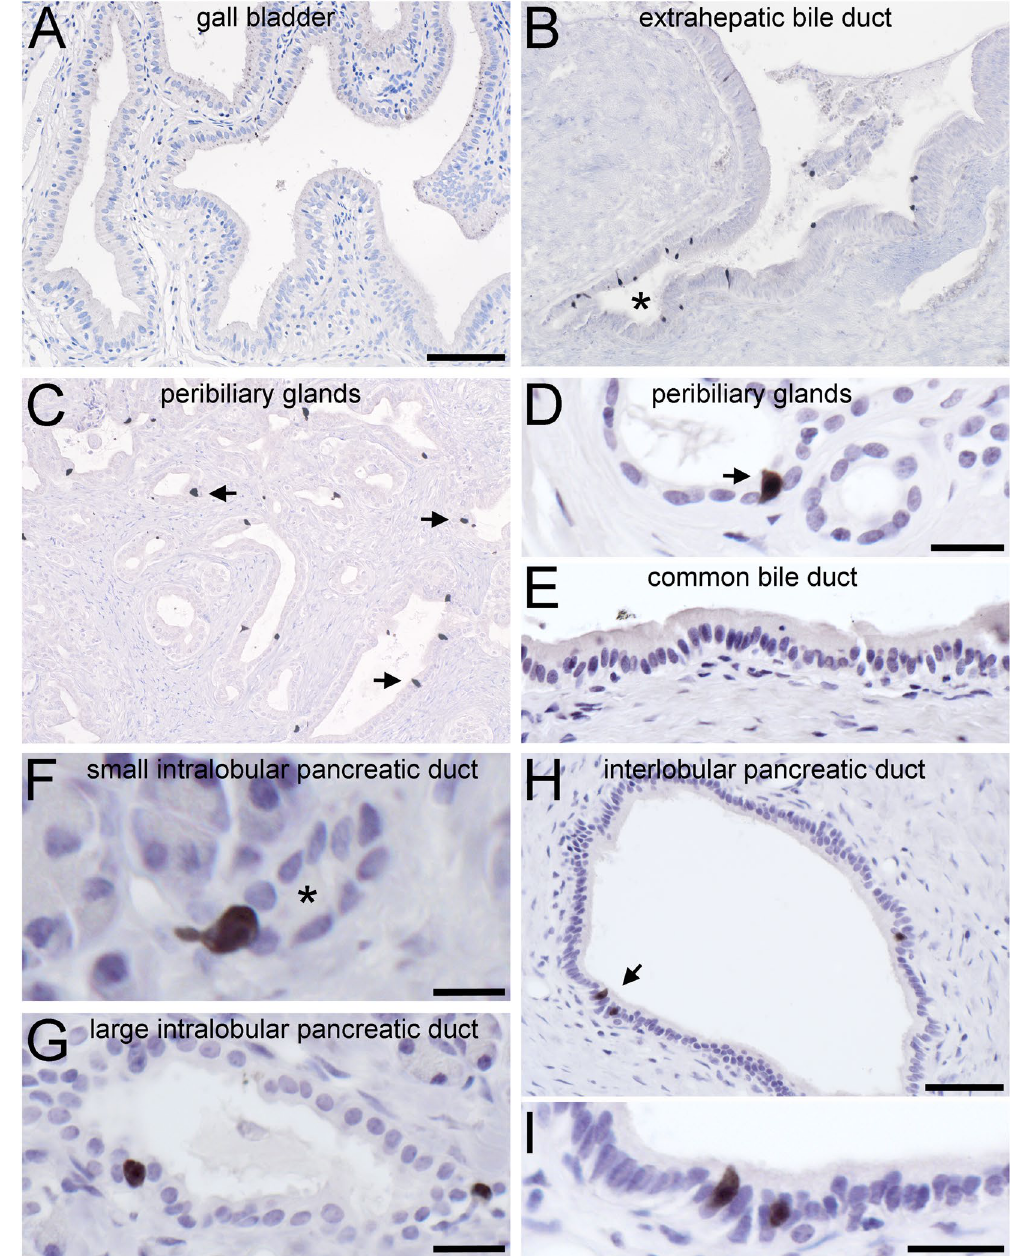
Figure 2. Presence and distribution of ChAT-immunoreactive cells in human extrahepatic biliary and pancreatic ducts. ( A ) ChAT immunoreactive (ir) cells are absent from the main gall bladder epithelium, but ( B ) are present at the exit sites of extrahepatic peribiliary glands (marked by asterisk). ( C ) Solitary ChAT-ir cells display a scattered distribution in the walls of extra-hepatic peribiliary glands. ( D ) The morphology of such a flask-shaped cell (marked by arrow) in higher magnification. ( E ) ChAT-ir cells are absent from the wall of the common bile duct. ( F , G ) ChAT-ir cells are numerous in small ( F , labeled by asterisk) and medium ( G ) diameter intralobular pancreatic ducts. ( H , I ) In the wall of interlobular pancreatic ducts they are found as solitary cells (marked by arrow in H , and magnified in I ), but are absent from the common pancreatic duct (not shown). For ChAT detection, the goat-anti-ChAT antiserum was used. The bar in A equals 100 µ m and also applies to B and C . The bar in ( D) equals 20 µ m and also applies to E and G . The bar in ( F) equals 10 µ m, in ( H ) equals 50 µ m, and in ( I ) equals 20 µ